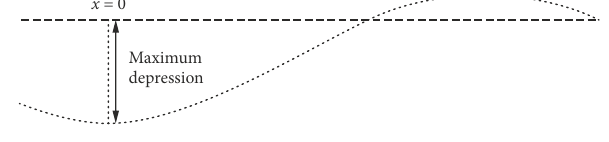
Figure 10. Continuous elastic beam model Table 5. Additional elastic beam